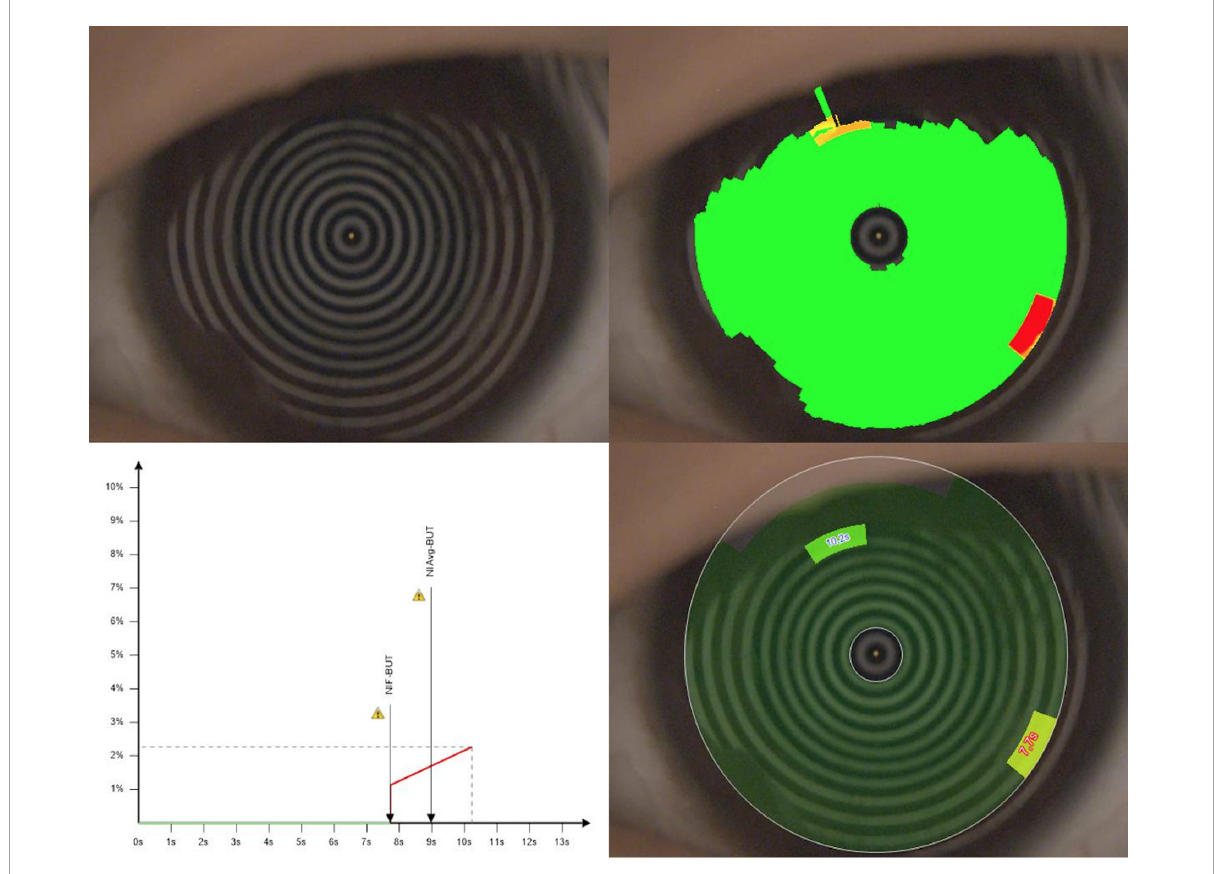
FIGURE1 The first tear break-up time (f-TBUT) and average tear break-up time (a-TBUT) measured with the Keratograph 5M